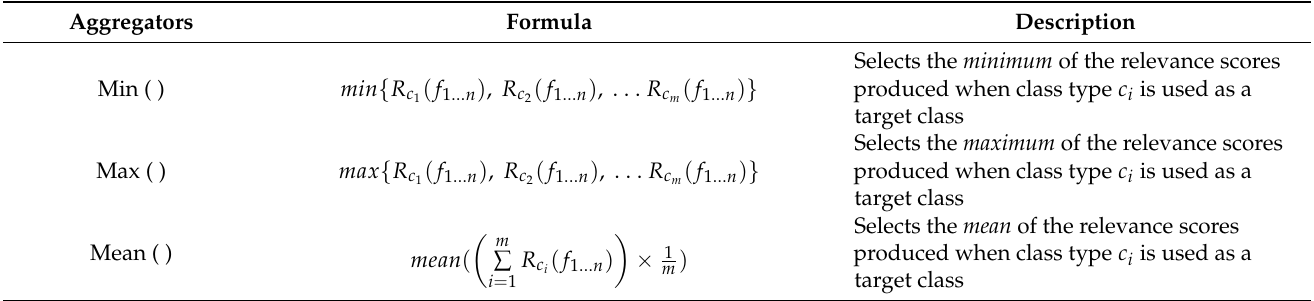
Table 3. Rank aggregation